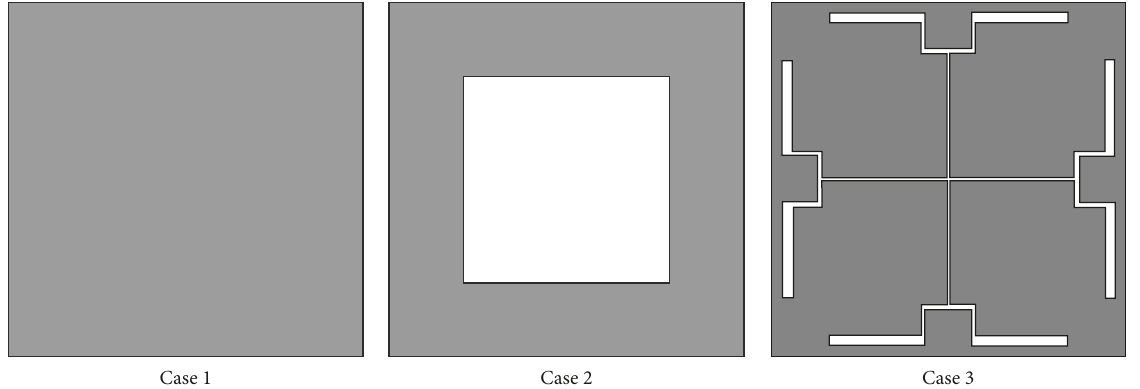
Figure 3: Three types of implantable microstrip patch antenna cases.